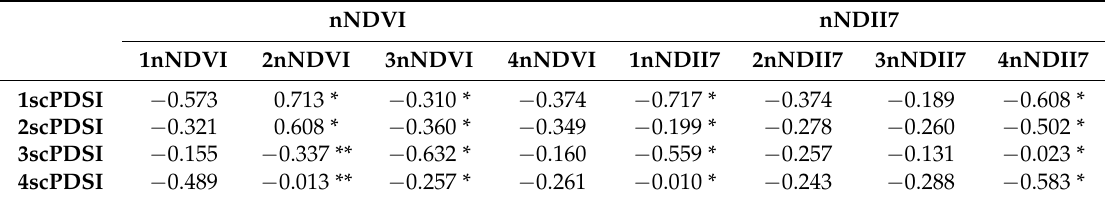
Table 1. Correlation among the scPDSI scores and first four PCs obtained through the covariance-matrix based PCA of the nNDVI (z-score normalized vegetation season NDVI) and nNDII7 (z-score normalized vegetation season NDII7) time series. Linear correspondence was calculated for yearly averaged time series.